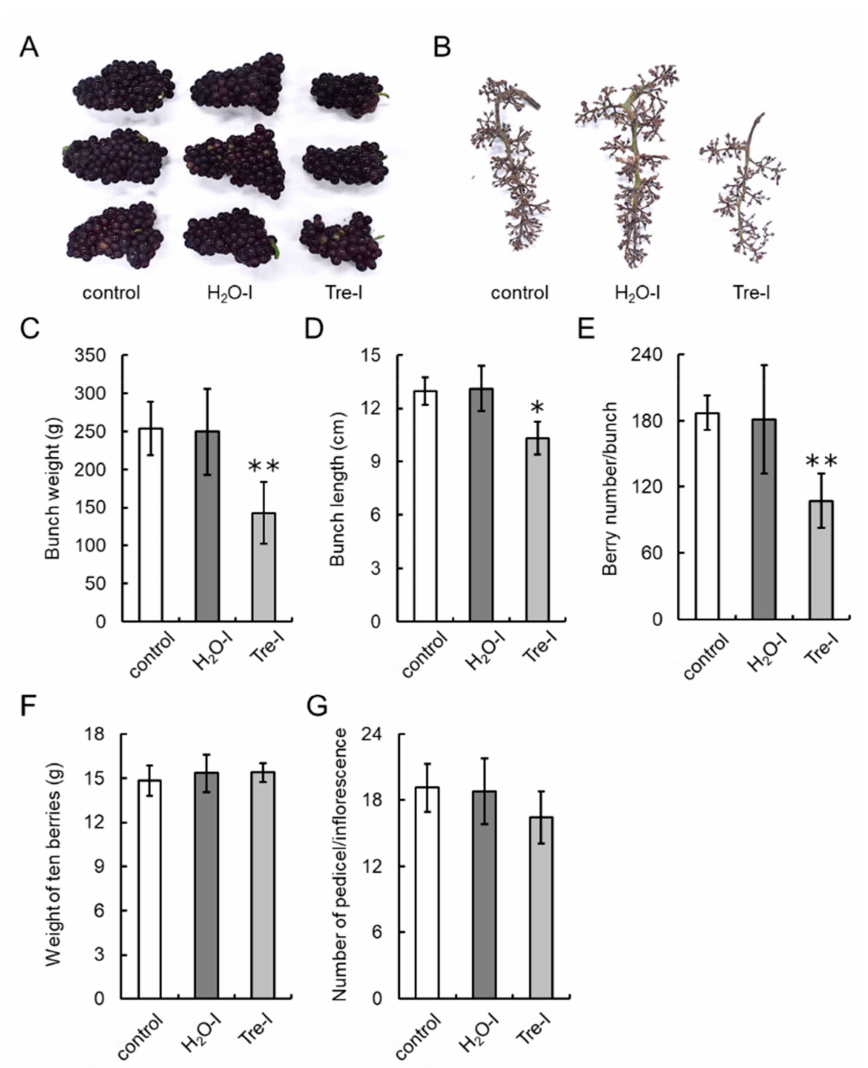
Figure 9. E ff ects of trehalose injection into buds nearing bud break on bunch characteristics in the 2020 growing season. Ten grapevine buds nearing bud break (Eichhorn–Lorenz Stage 3) were treated with 10% trehalose or water using a microsyringe or an atomizer on 8 April 2020. Young shoots (Eichhorn–Lorenz Stages 5–7) from the buds were again treated with trehalose or water using an atomizer 10 days post first treatment. Twenty bunches from ten shoots (two bunches / shoot) were collected at harvest (Eichhorn–Lorenz Stage 38). ( A ) Photograph of bunches at harvest. ( B ) Photograph of inflorescences. ( C ) Bunch weight. ( D ) Bunch length. ( E ) Number of berries per bunch. ( F ) Weight of ten berries. ( G ) Number of pedicels per inflorescence. Bars indicate means ± standard deviations of twenty bunches. * p < 0.05 compared with control (Dunnett’s test). ** p < 0.01 compared with control (Dunnett’s test). Control, non-treated grapevines. H2O-I, water-injected grapevines. Tre-I, trehalose-injected